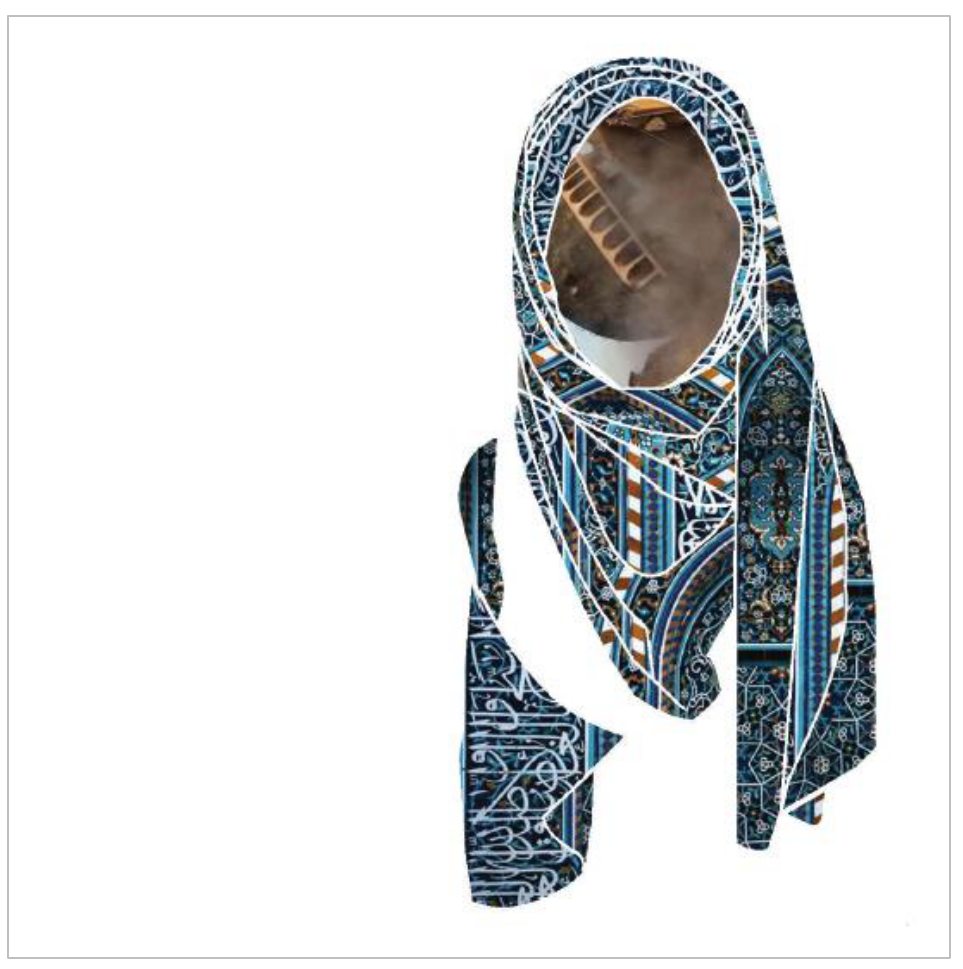
Meghan Kozal, Destruction , 2017, Graphic